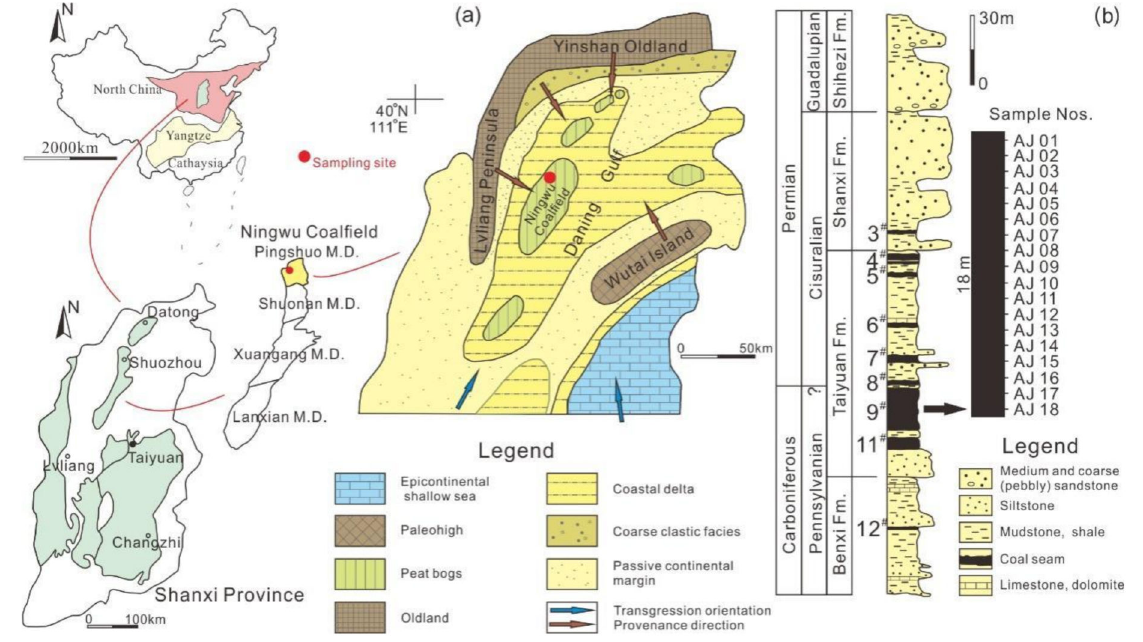
Figure 1. ( a ) Location of sampling site in Anjialing surface mine in Pingshuo Mine District and paleogeographic map of Ningwu Coalfield (modified from Zhuang et al. [65]). ( b ) Lithological column of Carboniferous (Pennsylvanian) to Permian (Guadalupian) in Anjialing surface mine and sampling horizons in No. 9